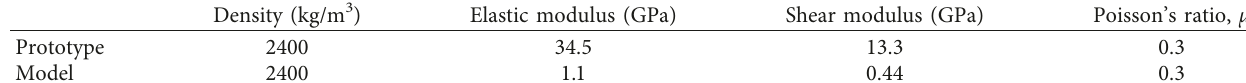
Table 4: Material properties of the lining segments.